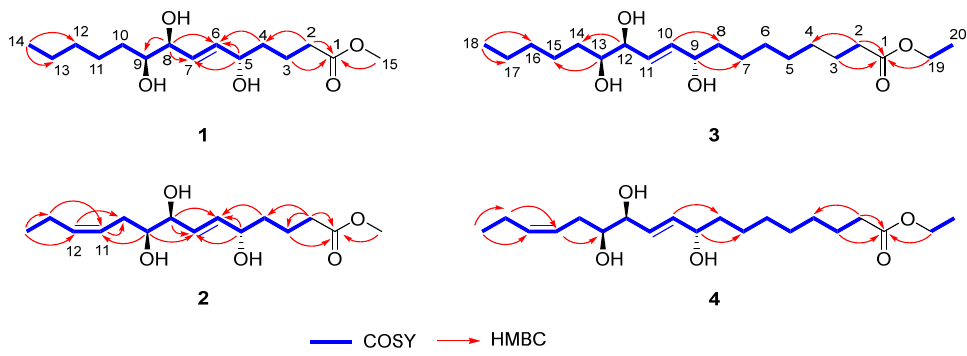
Figure 2. Key 1 H- 1 H COSY and HMBC correlations of 1–4.